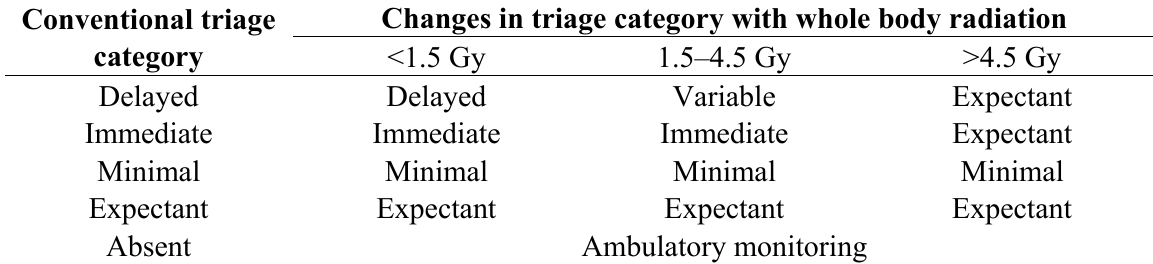
Table 5. Triage categories for combined injuries dependent on radiation dose